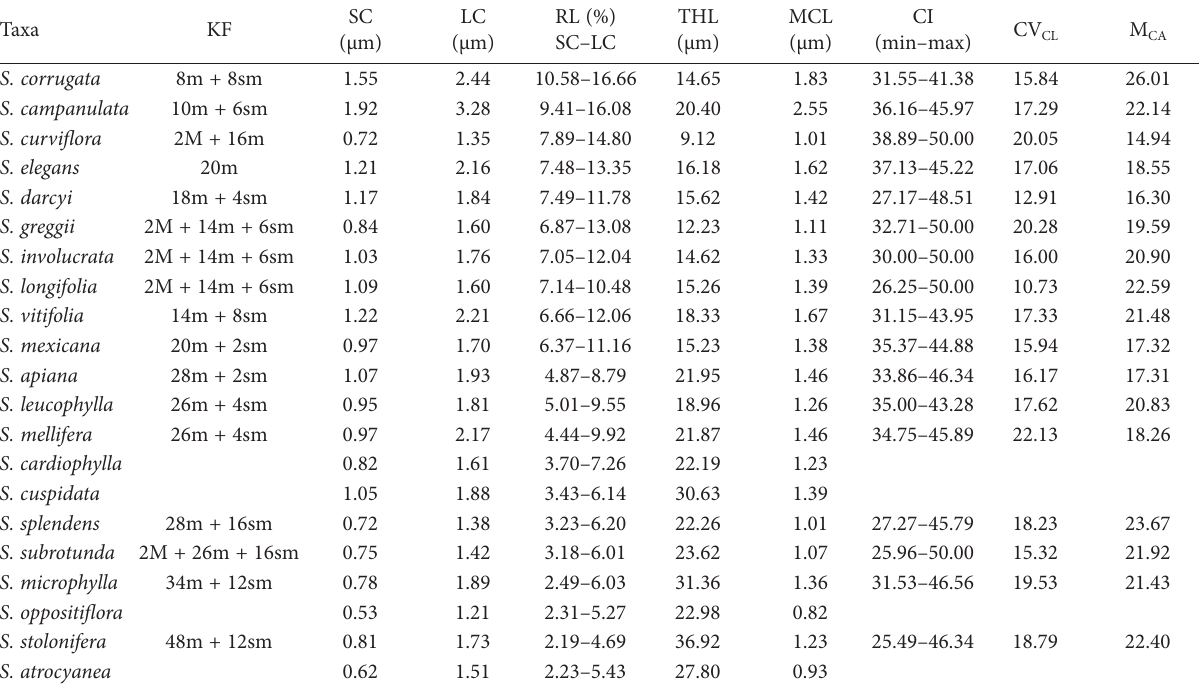
Table 2. The karyological features of the studied Salvia taxa; karyotype formula (KF), shortest chromosome length (SC), longest chromo- some length (LC), relative length (RL), total haploid chromosome length (THL), mean chromosome length (MCL), centromeric index (CI), coefficient of variation of chromosome length (CV CL ), mean centromeric asymmetry (M CA ), median point (M), median (m), submedian